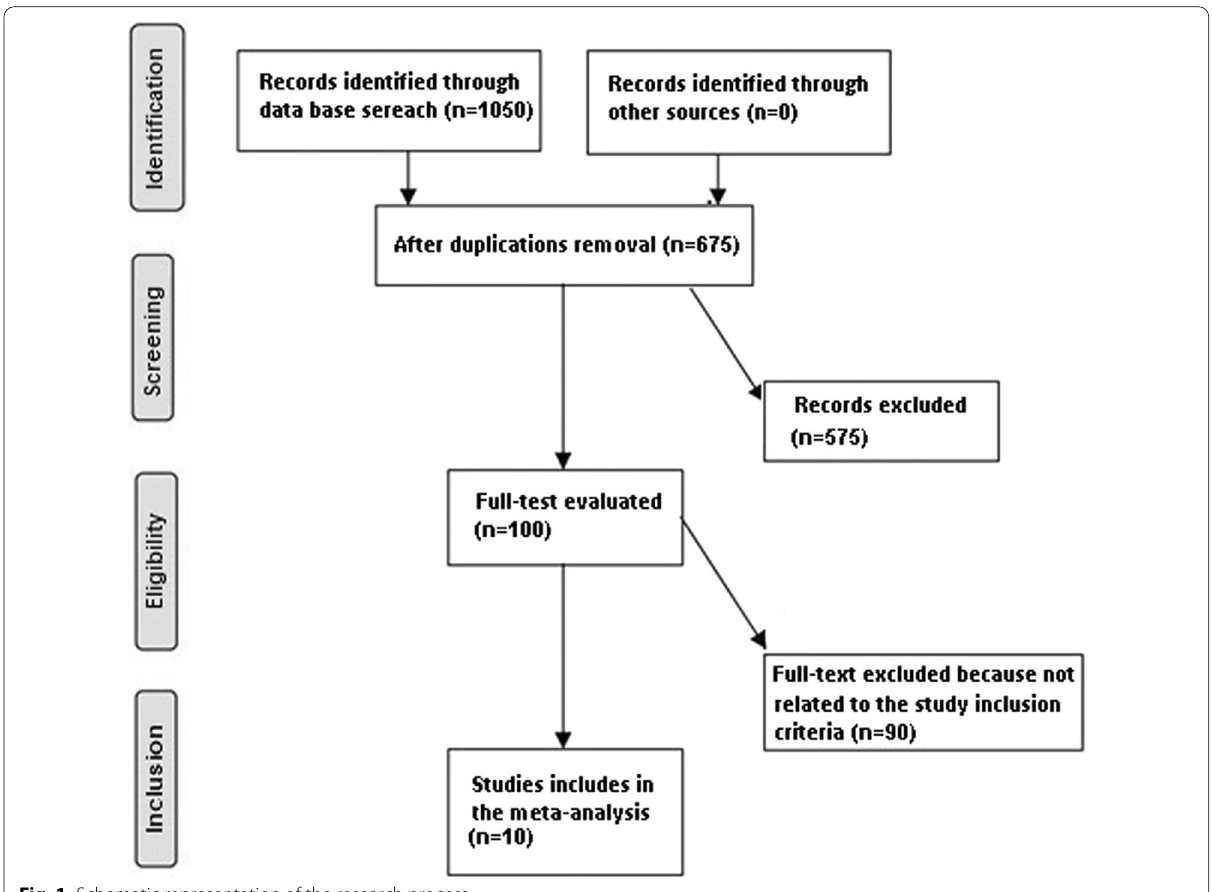
Fig. 1 Schematic representation of the research process